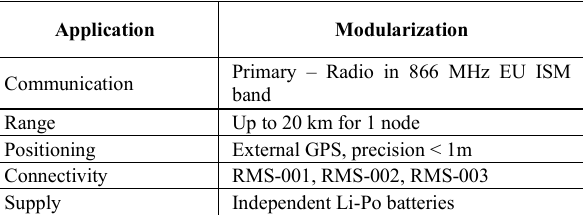
M AIN PARAMETERS OF THE RMS-000 MODULE [3]